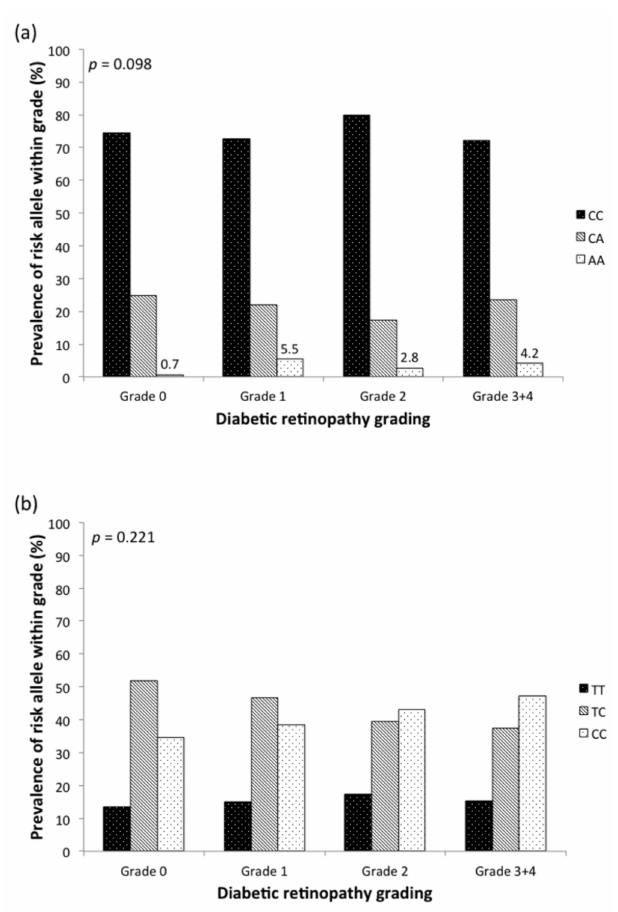
Figure 2. Comparison of the prevalence of risk alleles in different DR stages in T2DM patients ( a ) FTO rs8050136 ( b ) PSMD6 rs831571. DR grading as follows: Grade 0, no DR; grade 1, mild NPDR;